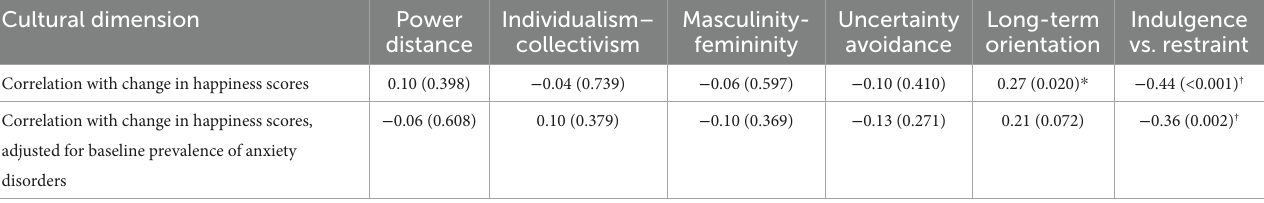
TABLE 4 Bivariate correlations between Hofstede’s cultural dimensions and the percentage of change in national happiness scores from 2017–18 to 2020–